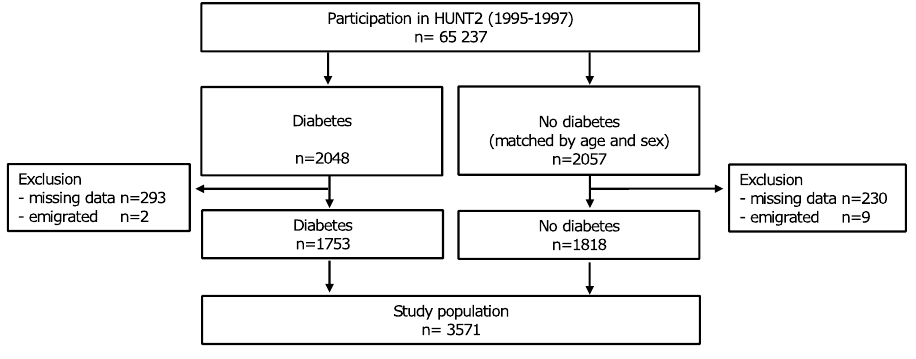
Figure 1. Inclusion of study